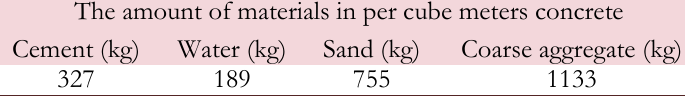
Table 1: Mix proportion of concrete specimens in test.